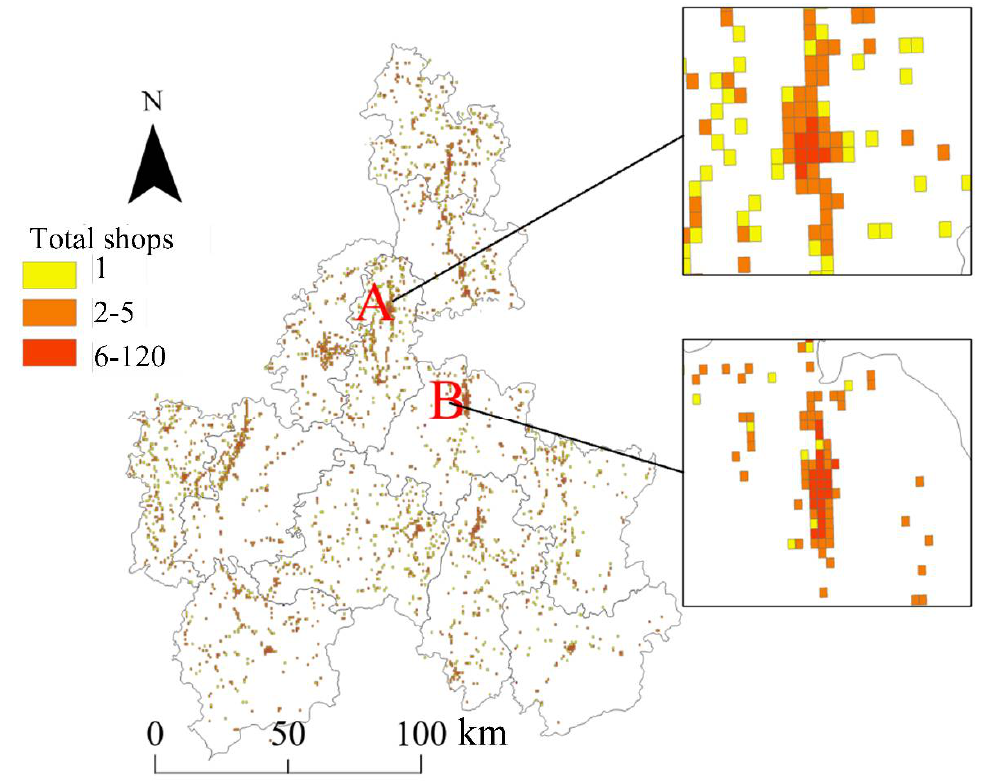
Figure 5. Number of shops in each grid.